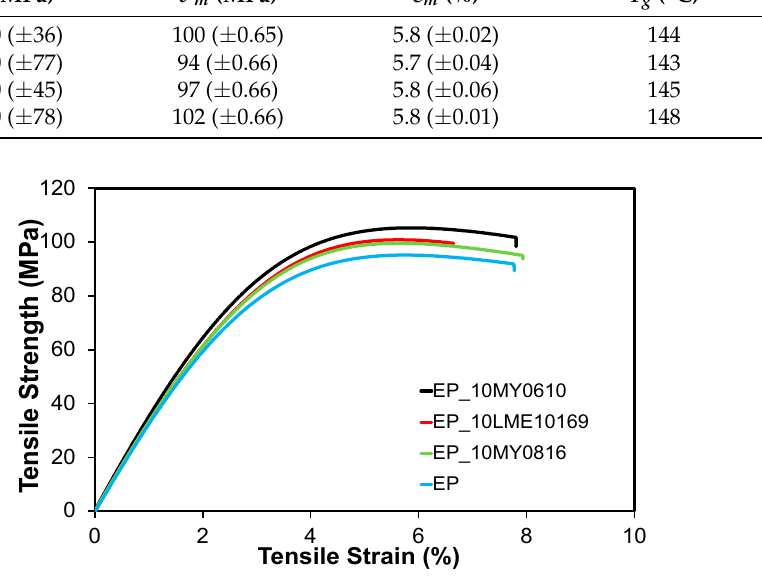
Figure 6. Representative stress–strain diagram for reference (EP) and 10 wt.% modified systems. (all tests were performed at 23 °C).